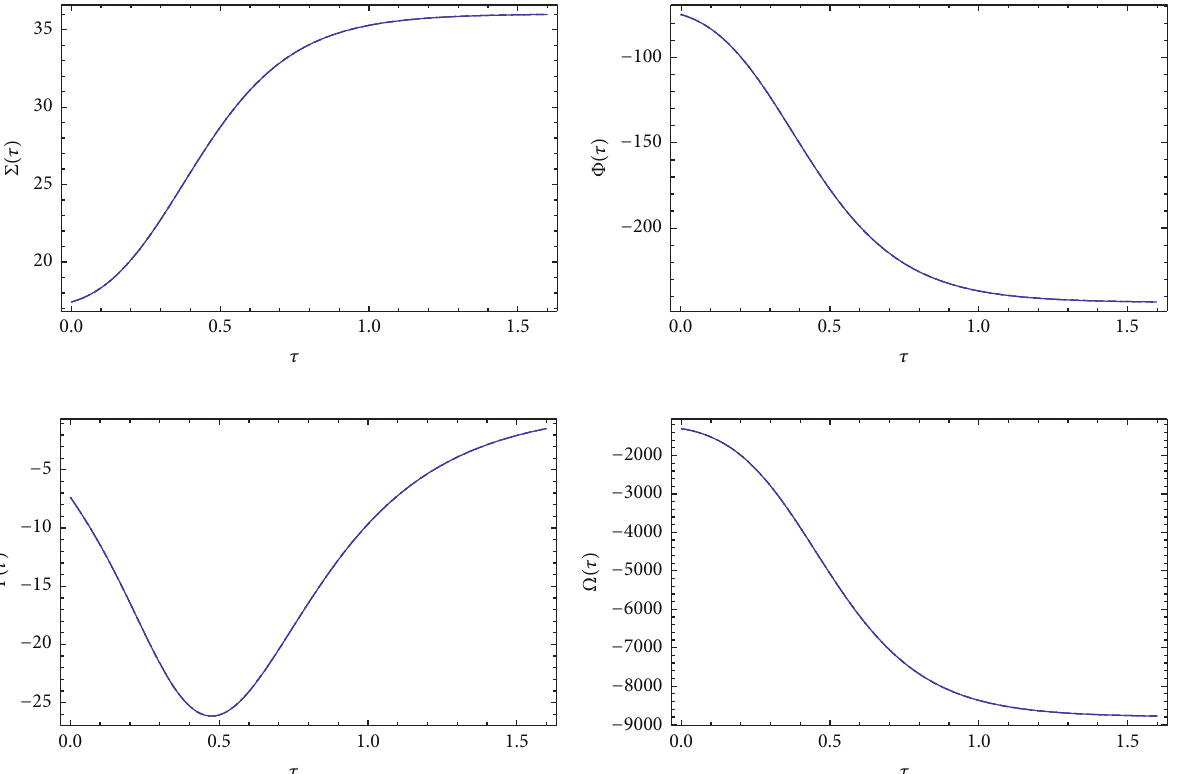
Figure 14: Time variation of the quantities (Σ,Φ,Ψ,Ω) , giving the Jacobi stability of the tachyon scalar field cosmological model with power law potential for different values of 𝛼 : 𝛼 = 0.8 (solid curve), 𝛼 = 1 (dotted curve), 𝛼 = 1.2 (dashed curve), and 𝛼 = 1.4 (dashed dotted curve),